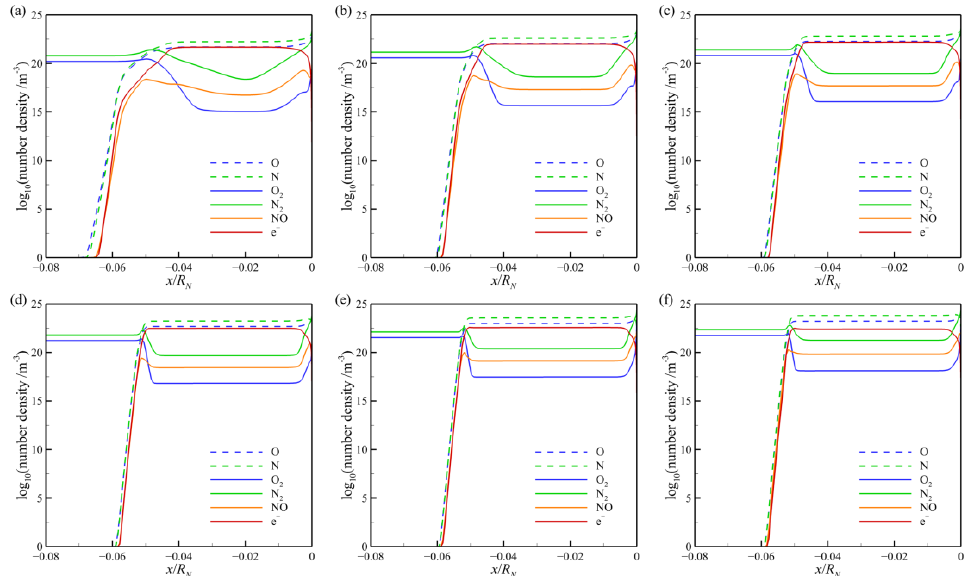
Figure 6. Number density of species along the stagnation line: ( a ) t = 1634 s; ( b ) t = 1636 s; ( c ) t = 1637 s; ( d ) t = 1640 s; ( e ) t = 1643 s; ( f ) t = 1645 s.